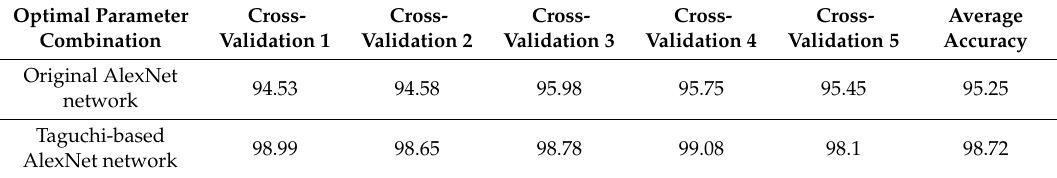
Table 10. Accuracy of the optimal parameter combination in the MORPH database.